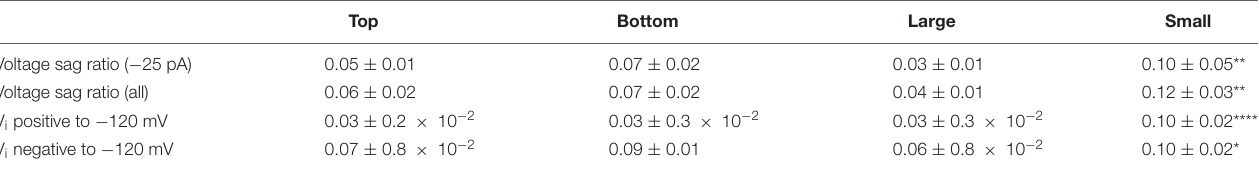
TABLE 4 | I H properties of OB DA neurons. Top Bottom Large Small Voltage sag ratio ( − 25 pA)